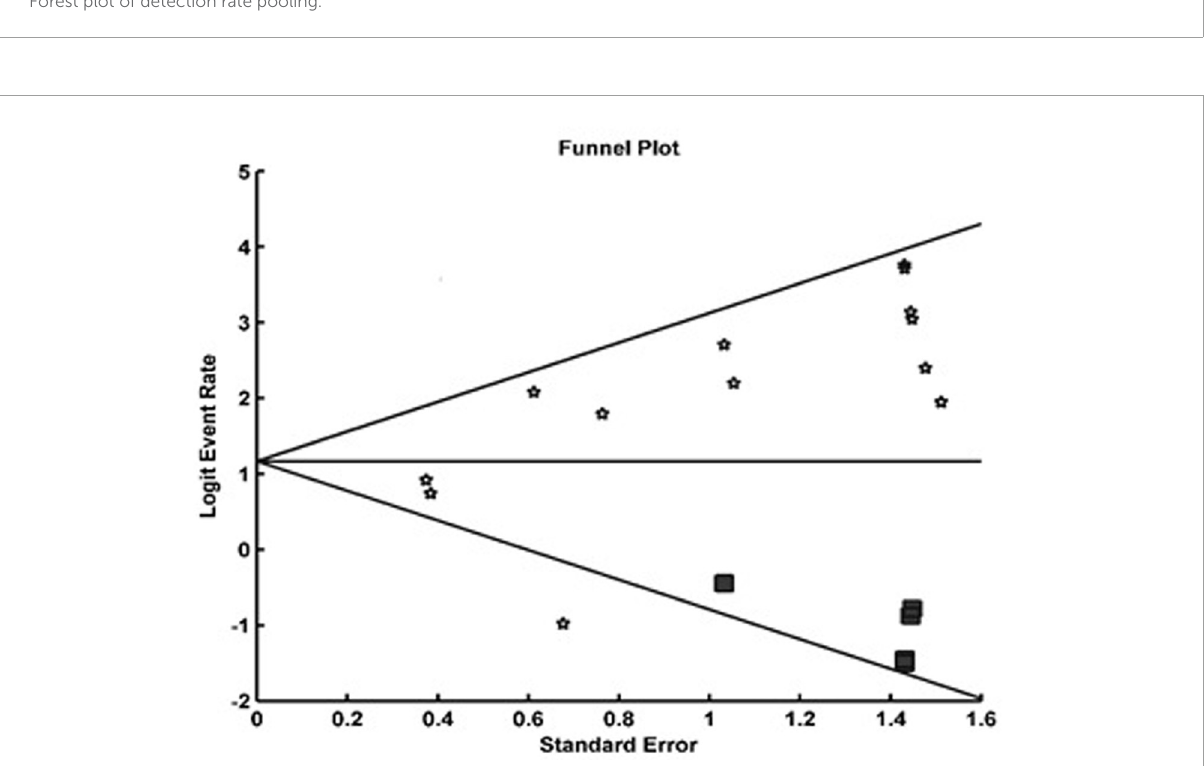
FIGURE3 Funnel plot of detection rate pooling using trim and fill